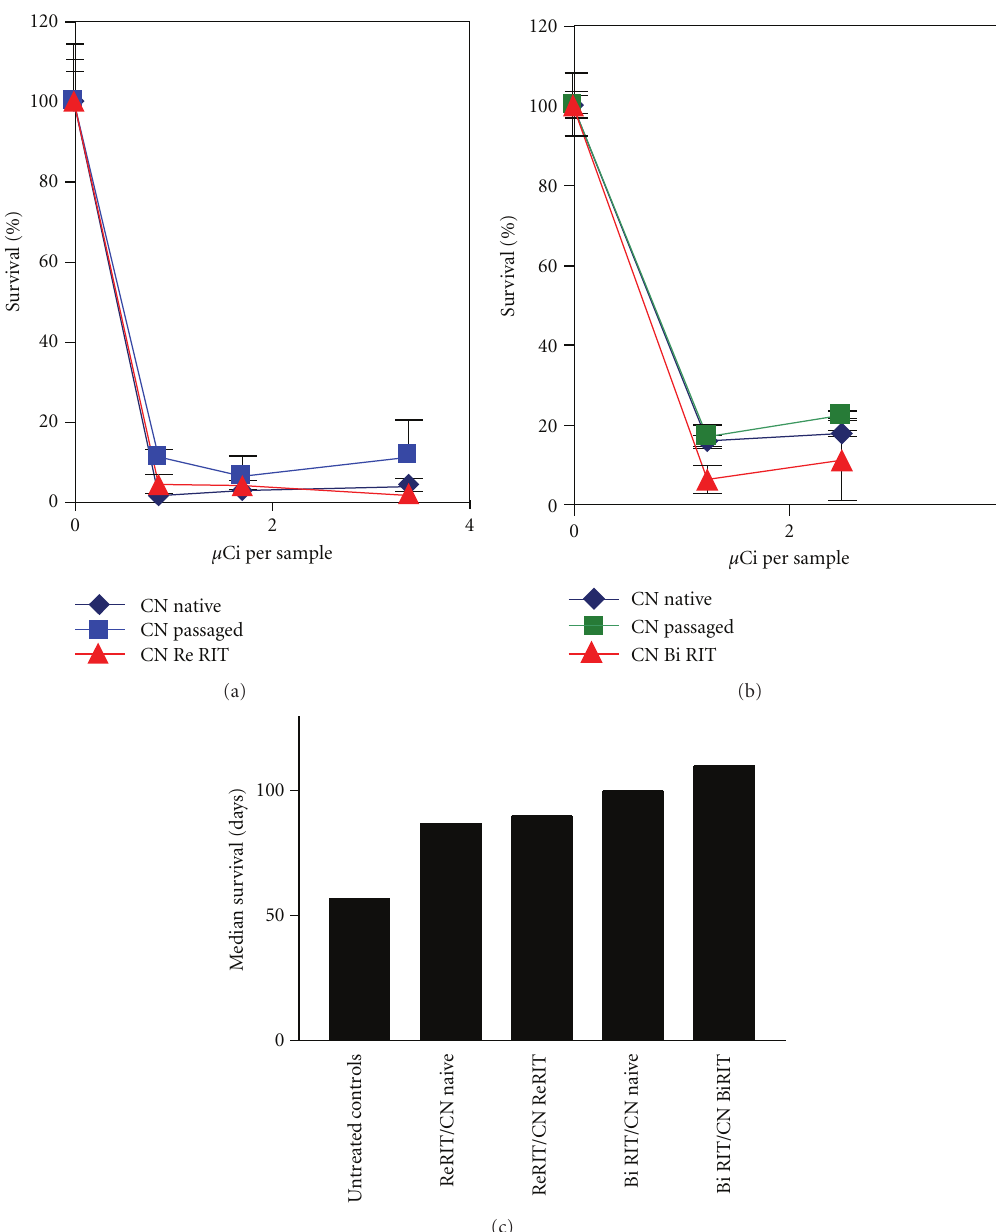
Figure 3: Investigation of possible resistance to RIT of CN in vivo and in vitro: (a) in vitro killing of CN cells with 188 Re-18B7 mAb. Each sample contained 10 5 fungal cells; (b) in vitro killing of CN cells with 213 Bi-18B7 mAb. Each sample contained 10 5 fungal cells; (c) median survival of AJ/Cr mice infected IV with 5 × 10 4 CN and treated 24hrs later with 150 μ Ci 188 Re-18B7 or 125 μ Ci 213 Bi-18B7 mAb. CN naive : cells from ATCC; CN passaged : cells recovered from untreated AJ/Cr mice; CN ReRIT : cells recovered from mice treated with 188 Re-18B7 mAb; CN BiRIT : cells recovered from mice treated with 213 Bi-18B7 mAb; Re RIT/ CN naive : mice infected with CN naive and treated with 188 Re-18B7; Bi RIT/ CN naive : mice infected with CN naive and treated with 213 Bi-18B7; Re RIT/ CN ReRIT : mice infected with CN ReRIT and treated with 188 Re-18B7; Bi RIT/ CN 213 Bi-18B7; adapted from BiRIT : mice infected with CN BiRIT and treated with